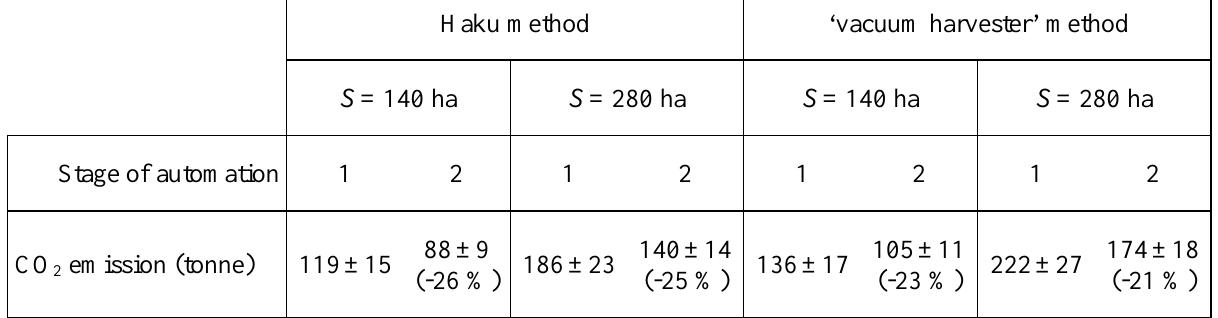
Table 4. CO 2 emissions from diesel usage during one extraction season for peat fields with surface areas ( S ) of 140 and 280 ha. The values in parentheses indicate the change in fleet CO 2 emissions that would accompany a change from Stage 1 (baseline) to Stage 2 automation, i.e. replacing conventional tractors with centrally controlled UGVs for milling and harrowing